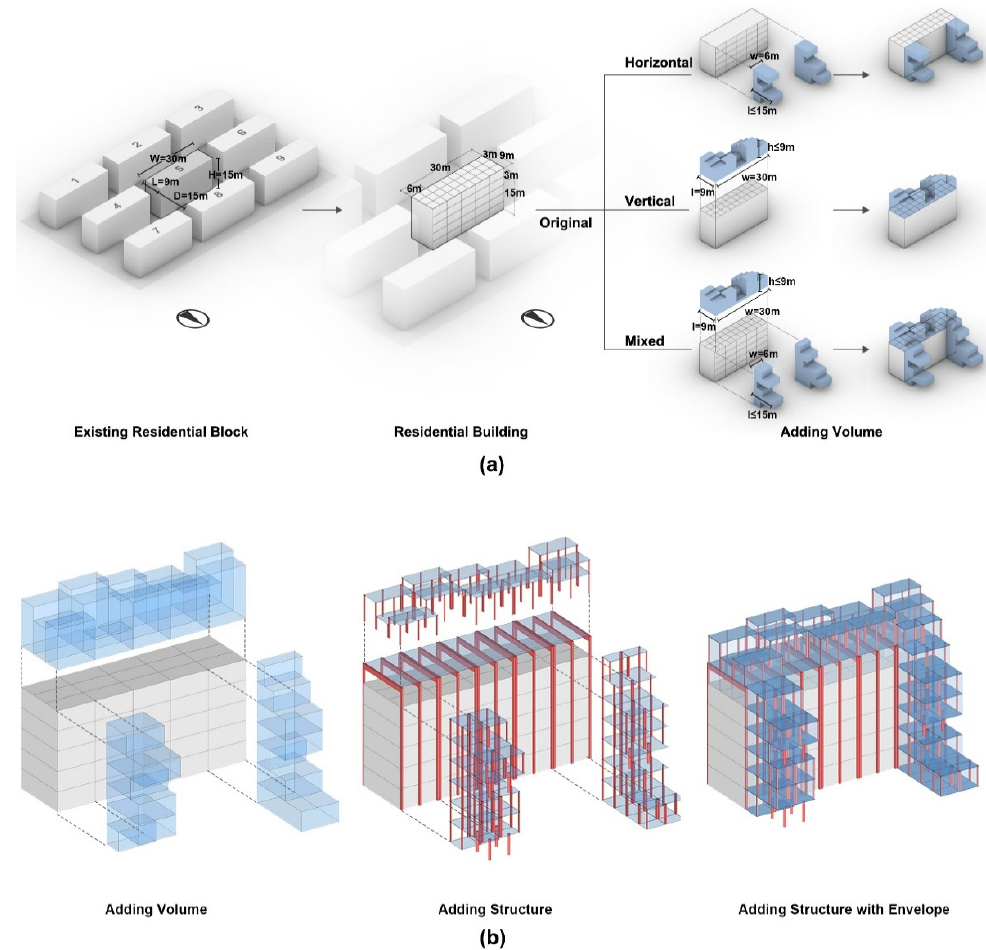
Figure 3. Illustration of the additional buildings of the existing urban block. ( a ) Three addition rules of the existing buildings. ( b ) The structure system of the additional buildings.